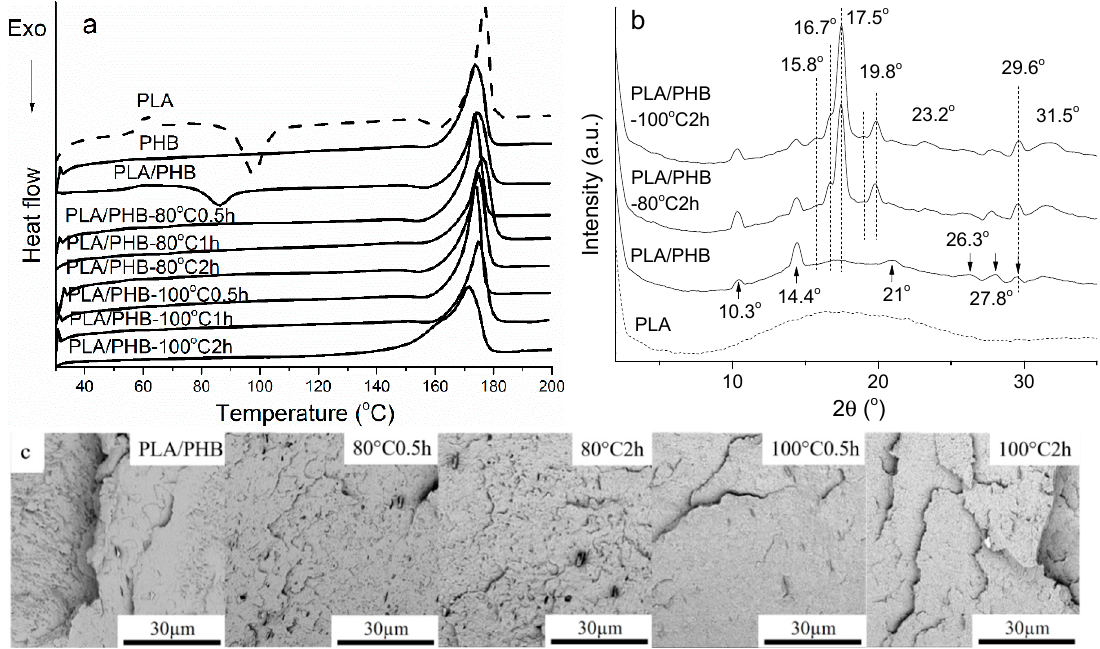
Figure 3. ( a ) Thermal curves, ( b ) Selected XRD curves, ( c ) Selected SEM images of PLA/PHB samples before and after annealing (between 0.5 and 2 h; 80 and 100 °C); additional DSC data are presented in Table S3.